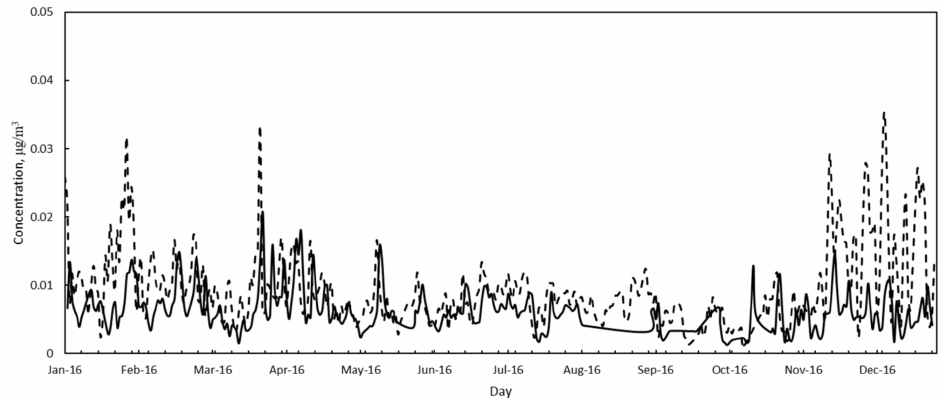
Figure 8. Lead daily average concentrations measured in the HI (dashed black line) and LI (solid black line) area during 2016 from the ARPAC network.